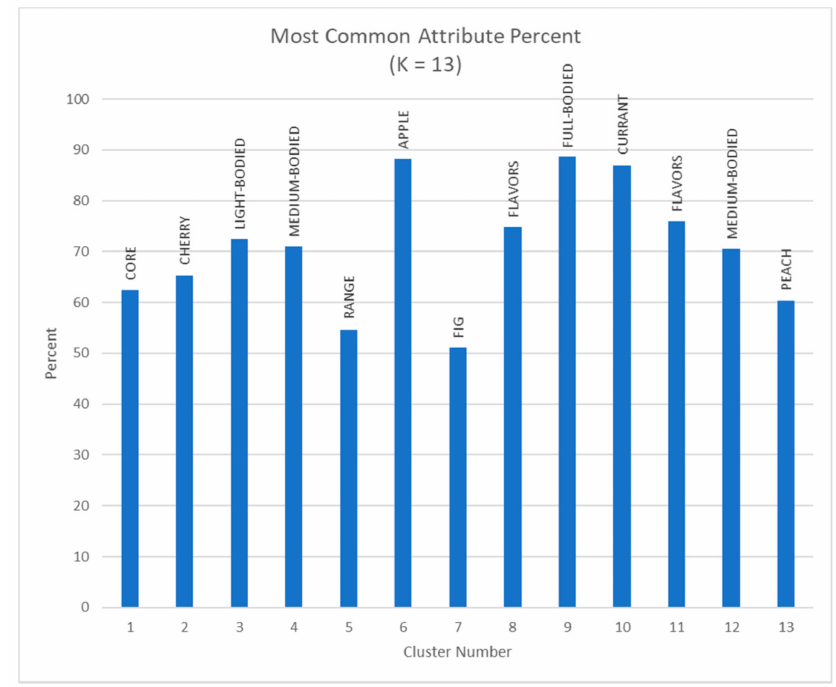
Figure 12. Most common attributes in each cluster when K = 13. The most common attribute percentages shown for each cluster label demonstrate that despite the changing K value, the program successfully groups the wines based on the most apparent attributes regardless of the increased diversity of the